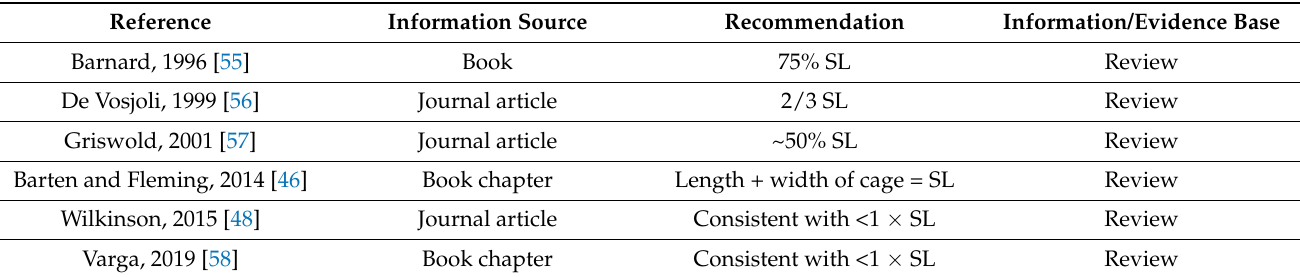
Table 4. Summary of findings for peer-reviewed * information sources and recommendations consistent with or specifying <1 × snake length (SL) minimum enclosure